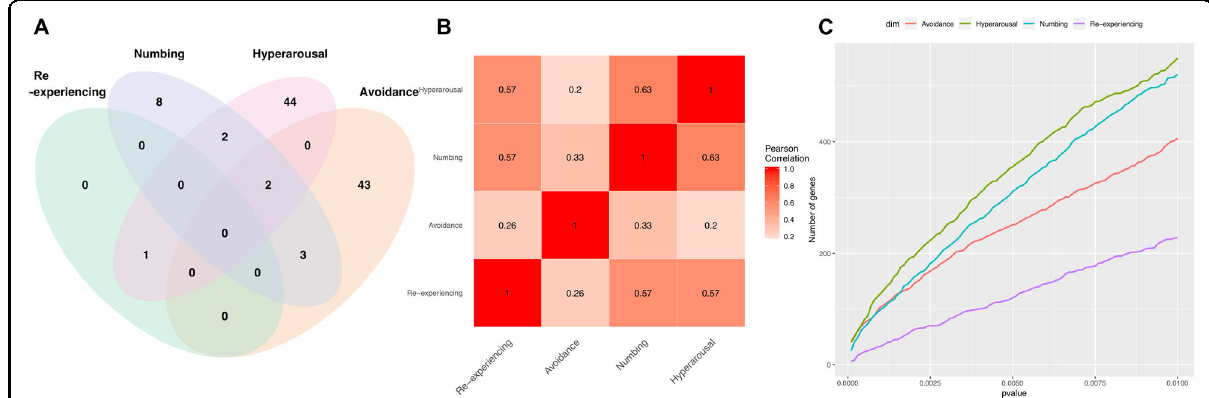
Fig. 2 Comparisons of DE genes associated with each PTSD dimension. A Venn diagram comparing the overlap among genes associated with re-experiencing, avoidance, numbing, and hyperarousal. B Pearson correlation coef fi cients comparing the negative log p values among re- experiencing, avoidance, numbing, and hyperarousal. C Number of signi fi cant genes at different p value